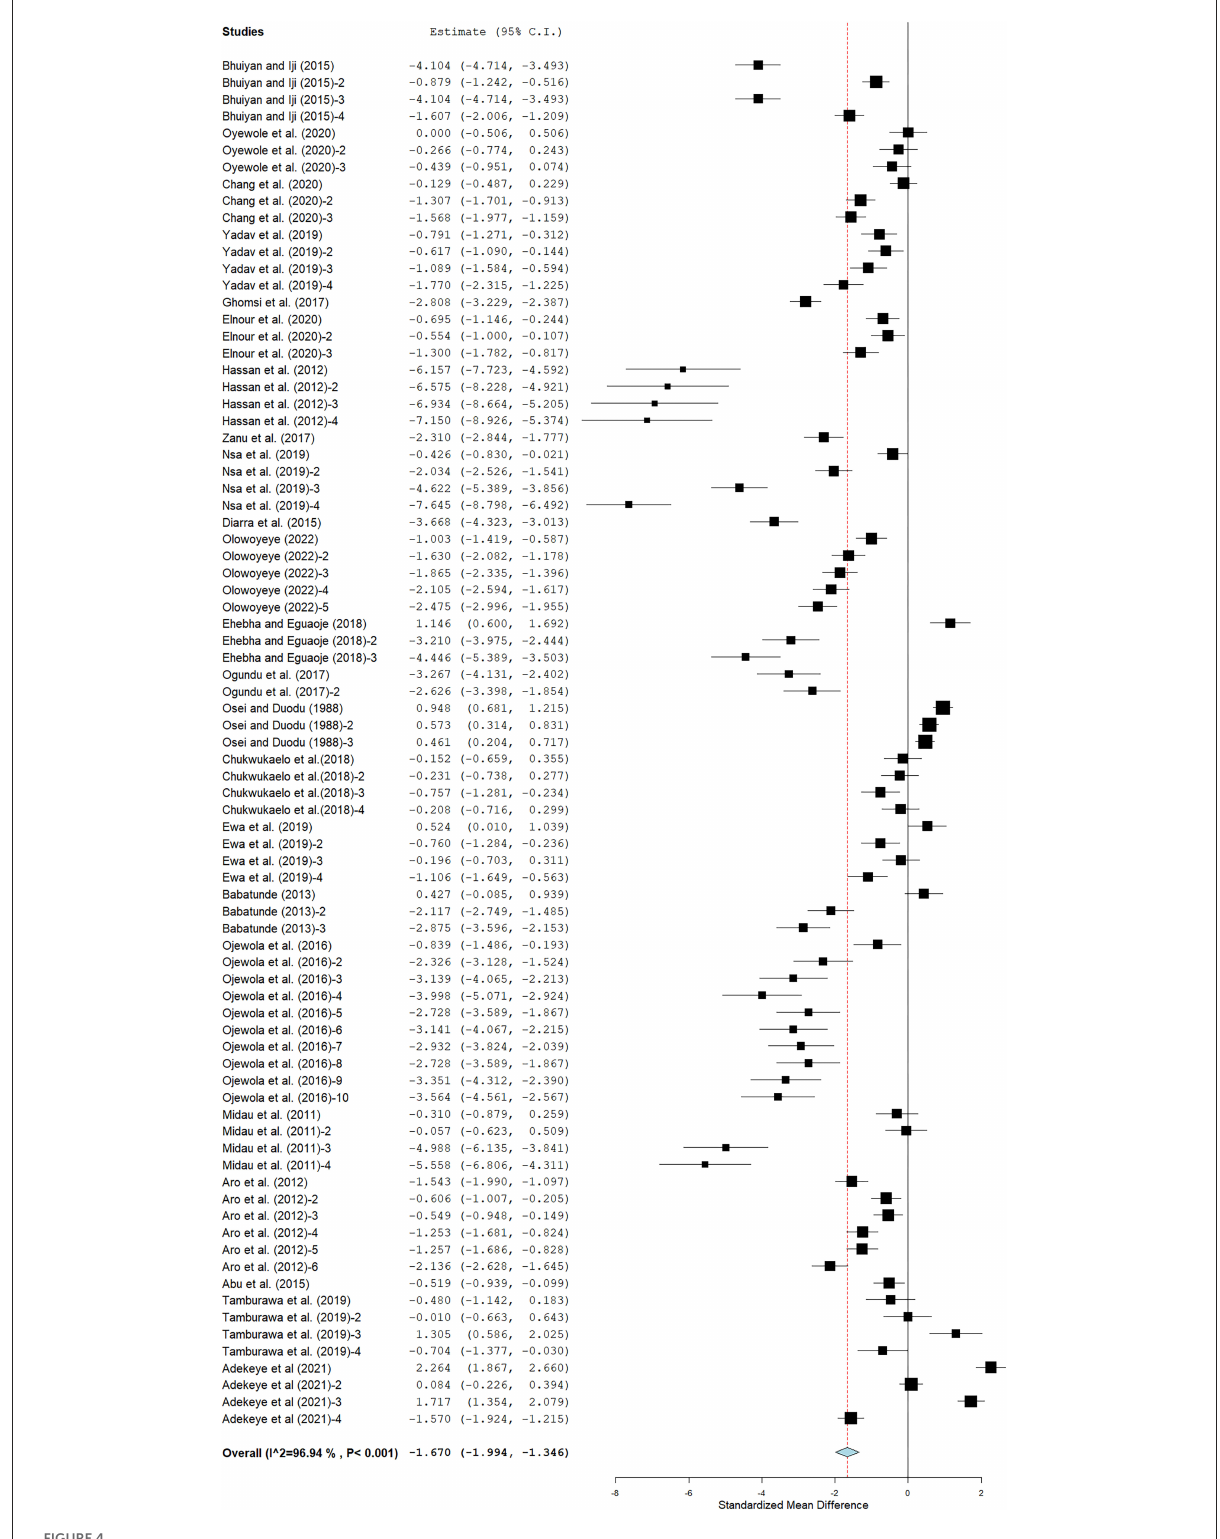
FIGURE4 MEB of the effect of cassava in broiler chicken diets on ADG. The thick vertical line is called the line of no effect. Plots to the left of the line of no effect show a reduction in ADG, whereas plots to the right of the line of no effect suggest an increase in ADG.